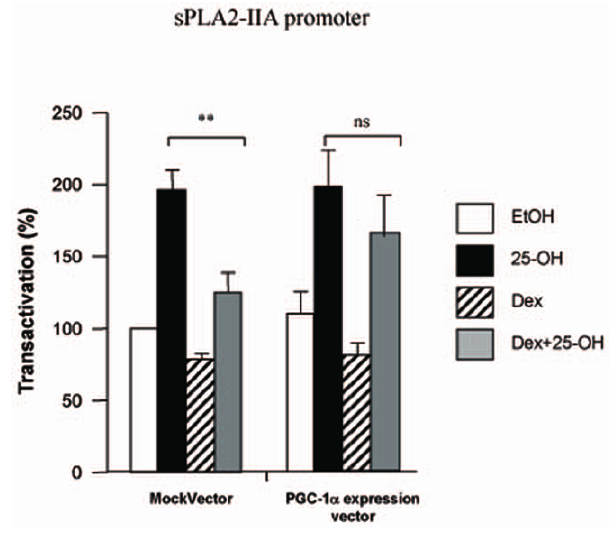
Figure 5. PGC-1 a implication in sPLA2-IIA promoter regulation. 158N cells were transiently transfected with 0.2 m g of sPLA2-IIA(1 kb), 0.1 m g of pRSV- b Gal plasmids and with 0.1 m g of PGC-1 a expression vector or mock vector, as indicated. Eighteen hours after transfection, cells were incubated with 25-OH (10 2 5 M) and/or Dex (10 2 6 M) for 24 h, and then luciferase and b -galactosidase activities were analyzed. Results are expressed as percentage of the basal activity; they represent the mean + / 2 SEM of at least four independent experiments performed in duplicate. **p , 0.01, when comparing between 25-OH and Dex + 25- OH using Bonferroni’s test after